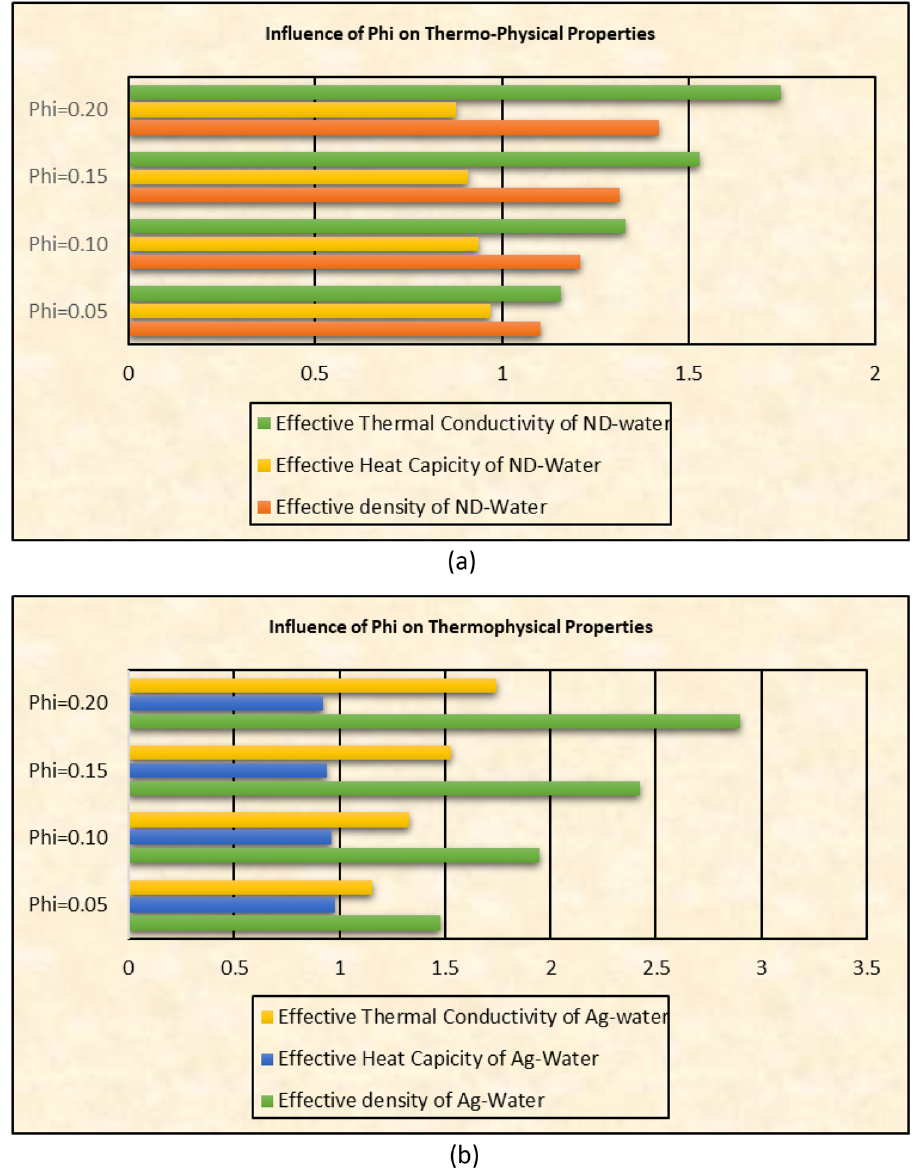
Figure 8. Influence of φ on thermophysical values of ( a ) ND-H 2 O and ( b ) Ag-H 2